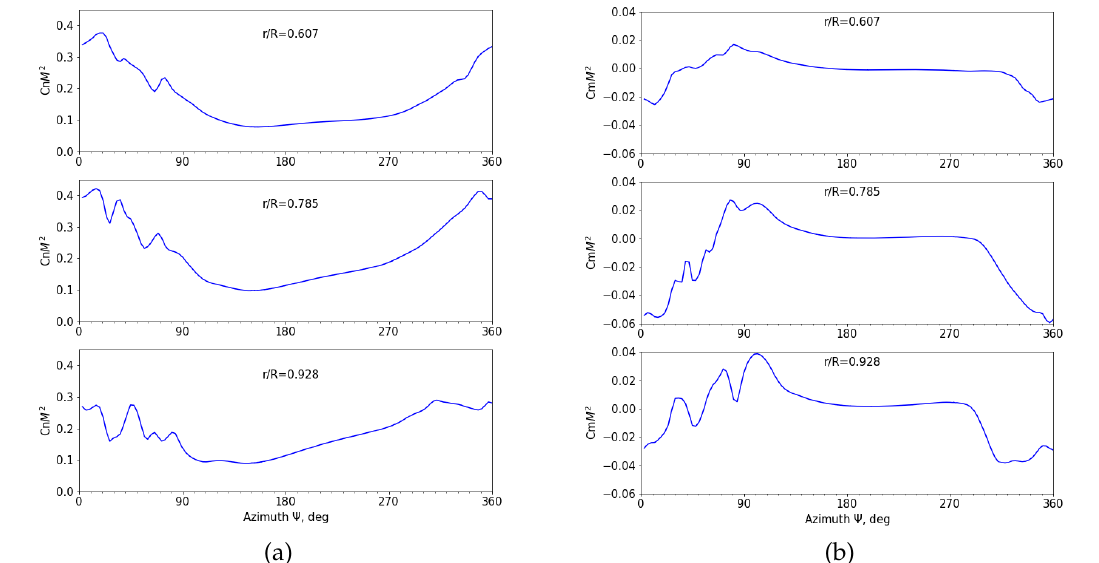
Figure 5. Sectional force coefficients at selected radial locations, r / R = 0.607, 0.785 and 0.928. ( a ): sectional normal force coefficient CnM 2 ; ( b ): sectional pitch moment coefficient CmM 2 .